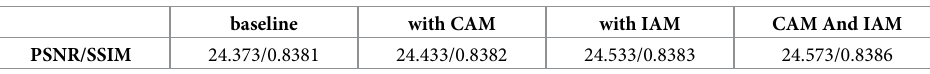
Table 1. Ablation study about the proposed CAM and